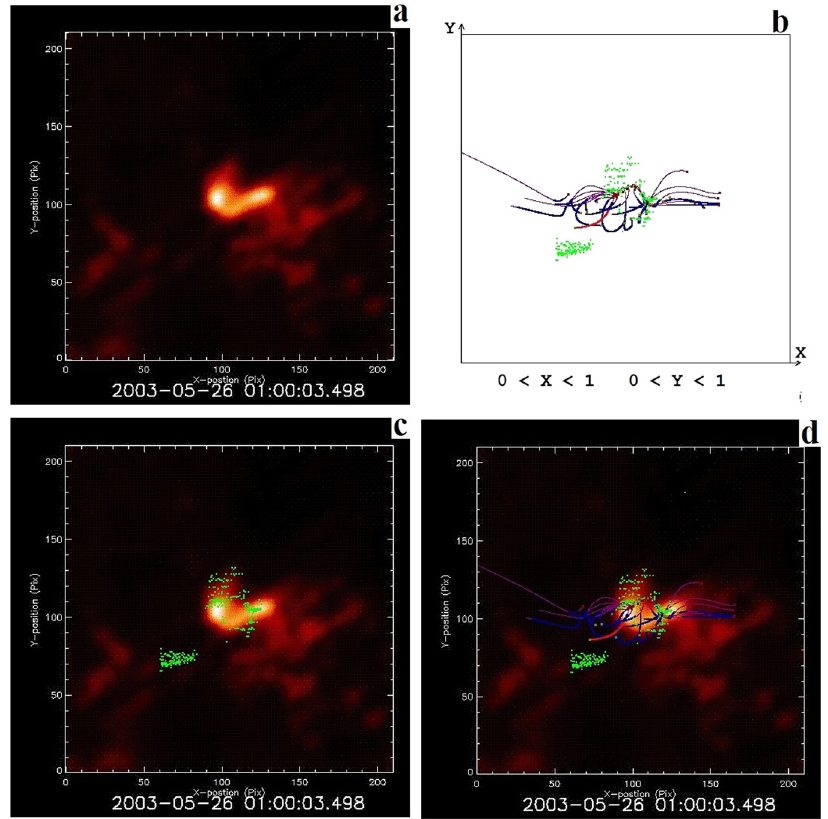
Figure 5: Comparison of the results of MHD simulation with observational data on the NoRH at 05/26/2003 01:00 in a square in the picture plane ( perpendicular to the line of sight ) in a square of size × 400 mm 400 mm ( linear size of the photospheric boundary of the compu - tational domain, taken as a unit of length ) . The center of the square is located on the solar disk in the center of the photospheric boundary of the computational domain at this moment in time. ( a ) The distribution of the intensity of radio emission at a frequency of 17 GHz, obtained with the NoRH. ( b ) The projections of the magnetic lines on picture the plane and the projections of the positions of the maximums of the current density, indicated by green dots. ( c ) Superposition of the positions of the current density maxima on the intensity distribution of radio emission at a frequency of 17 GHz. ( d ) Superimposing the projections of the magnetic lines and the positions of the current density maxima on the intensity distribution of the radio emission at a frequency of 17